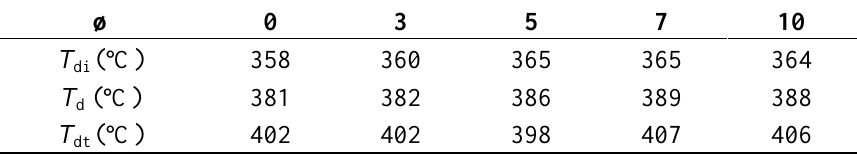
Table 2. Thermal decomposition parameters of composites.